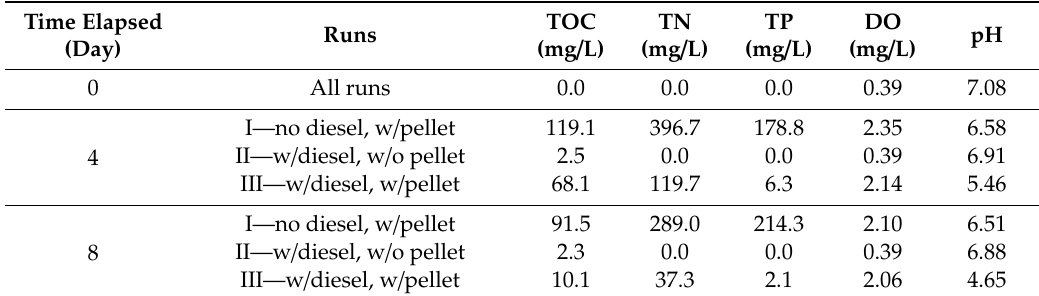
Table 4. Water quality at a depth of 10 cm during the first 8 days of TPH removal.